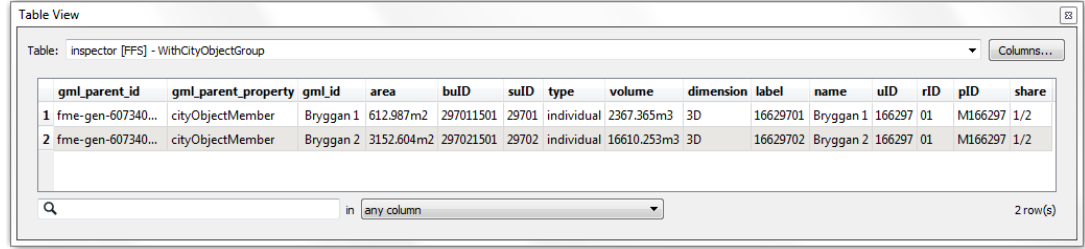
Figure 19. Integration of CityGML 3.0 with LADM based on CityObjectGroup .